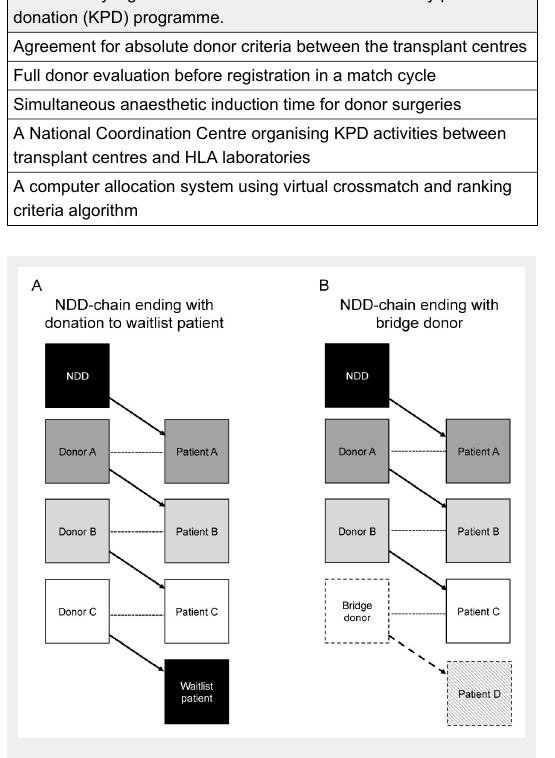
Figure 3 Multi-way exchanges beginning with a non-directed donor (NDD) and including multiple donor-recipient pairs. The closed chain donation model ends with the final donor donating to a patient on a deceased-donor wait list (A). The open chain model ends with a bridge donor that will start a new chain of transplants (B). --- incompatible pair; -> compatible pair; ---> next compatible